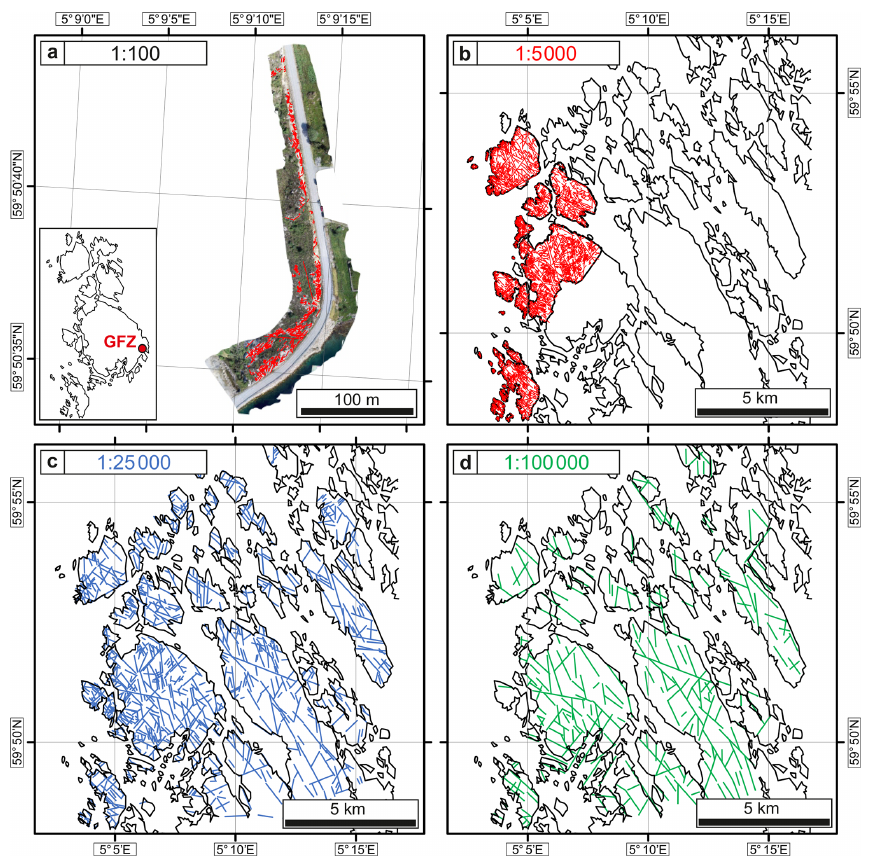
Figure 3. Lineament maps produced by manual lineament picking on outcrop orthophotos (a) and DTM from lidar surveys (b–d) .